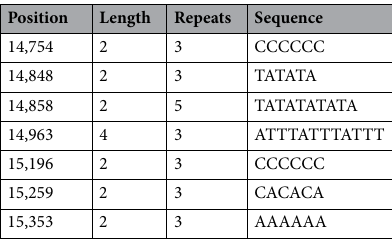
Table 6. Microsatellites in the control region.